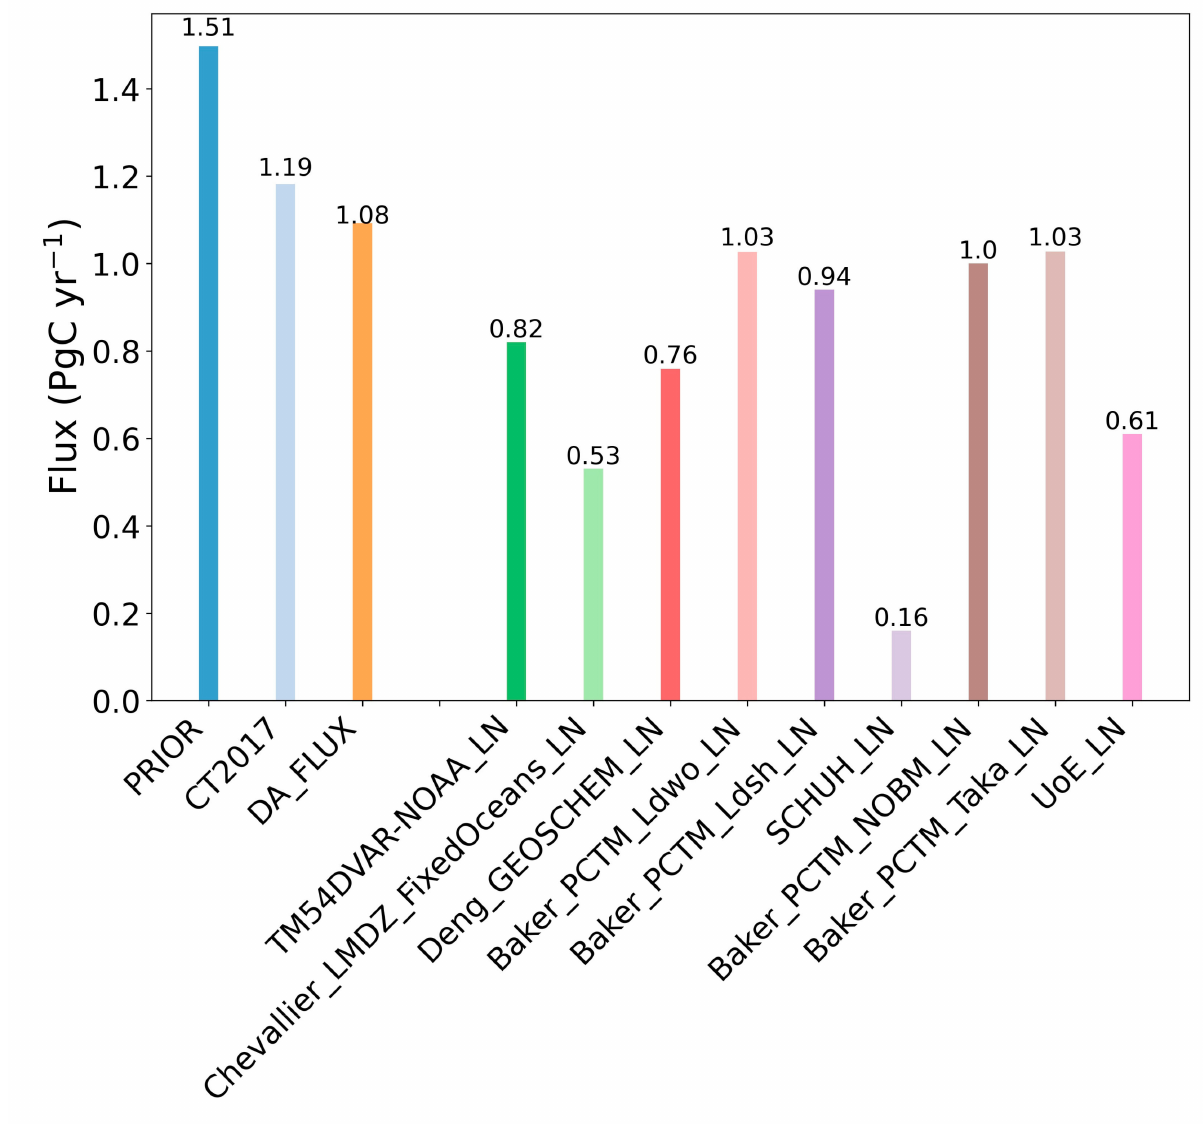
Figure 4. Comparison of the annual posterior CO 2 flux over the contiguous United States in 2016 estimated by the DA_FLUX experiment with those estimated by CT2017 and the models from OCO-2 MIP, and with the prior CO 2 flux used in the DA_FLUX